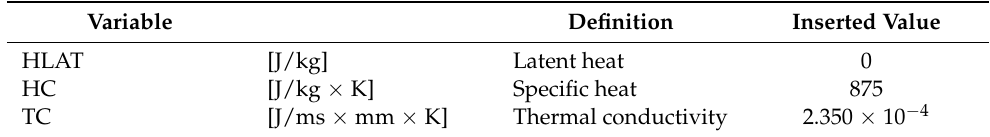
Table 8. T01 material parameters for the thermal isotropic characteristic of aluminum, as published in [35].